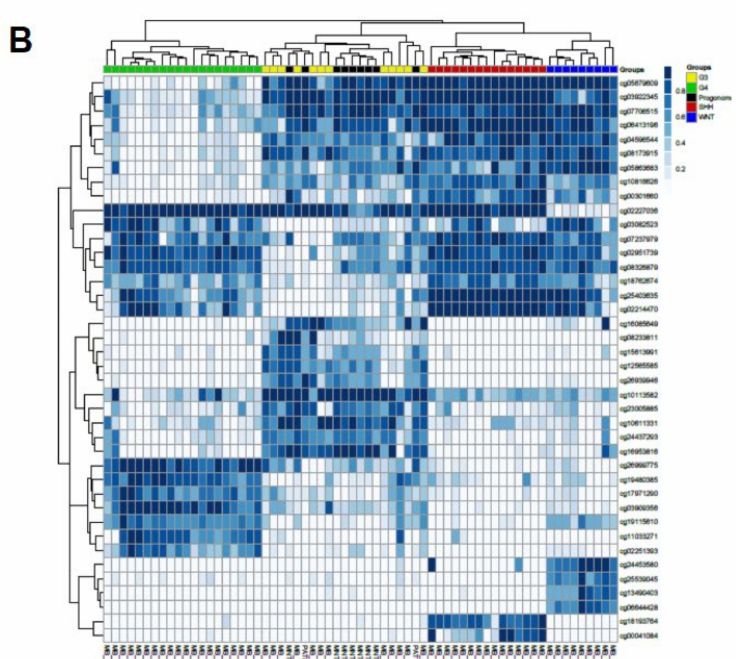
Figure 5. Multidimensional scaling (MS) analysis performed on the 1000 most variable probes of the whole-genome DNA methylation data shows a close similarity between (MNTI/PAT) and MBG3. Color legend of the MDS plot as follows: Progonoma (MNTI/PAT, black); WNT, Wingless MB (blue); SHH Sonic Hedgehog (red); G3, Group 3 MB (yellow); G4, Group 4 MB (green) ( A ). Hierarchical clustering and heatmap of beta values relative to the 39 high-quality CpG islands better discriminating MB subgroup in the Hovestadt set (Hovestadt et al.). The heatmap shows normalized methylation levels in MNTI/PAT samples and MB samples. Clusters were obtained by means of Ward’s minimum variance method using the Euclidean distance. Color legend: Progonoma (MNTI/PAT, black); WNT, Wingless MB (blue); SHH-A, Sonic Hedgehog MB (red); G3, Group 3 MB (yellow); G4, Group 4 MB (green) ( B ).